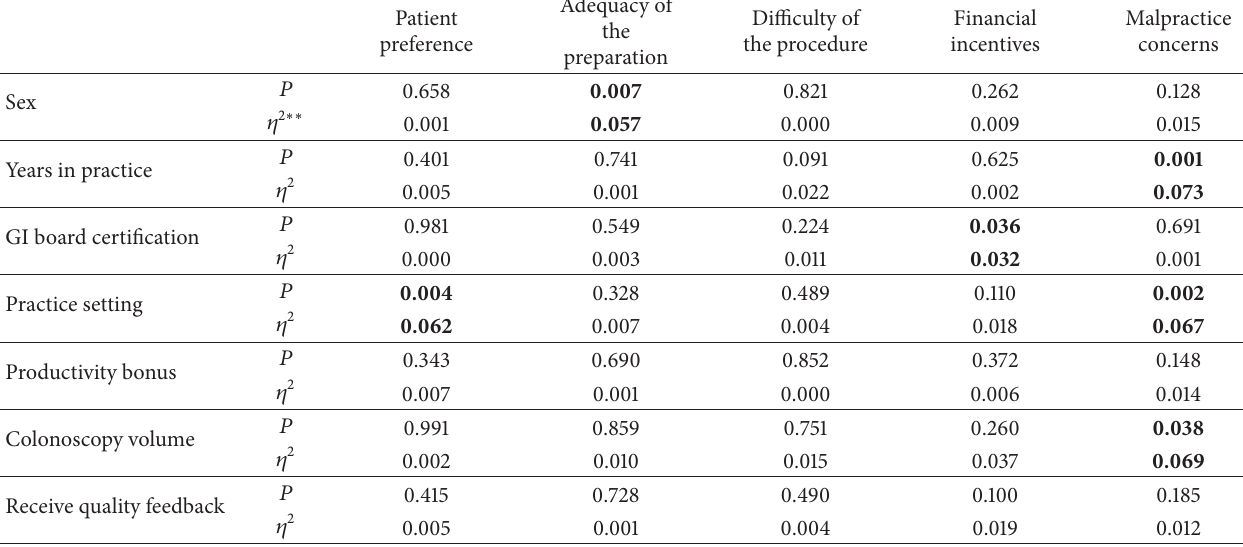
Table 6: Physician perceptions about colonoscopy surveillance recommendations ∗ .